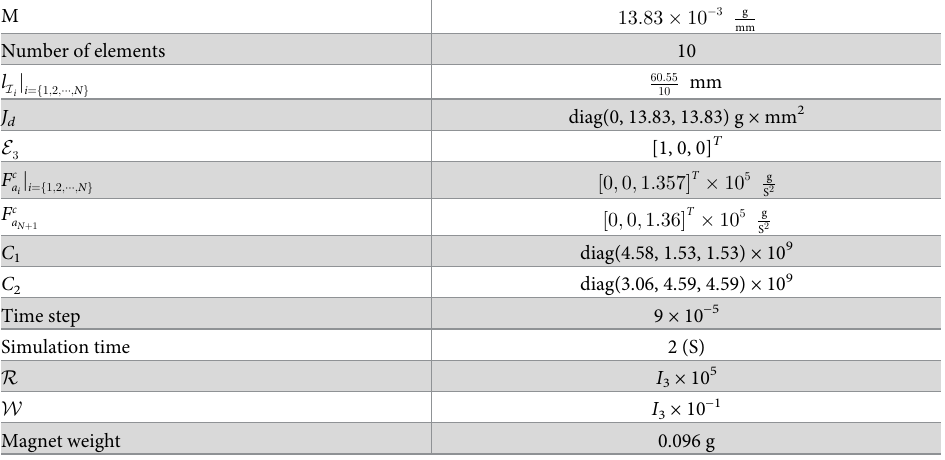
r ¼ 1000 kg , square cross-section with edge length a = 5 cm, Poisson’s ratio ν = 0.35, and m 3 Young’s modulus E = 5 × 10 4 KPa in the high frequency case and E hf pares the position between high and low-frequency cases. The base of the manipulator is fixed at the origin. From Fig 16, it is observed that by changing the Young Modulus from E tip motion is preserved but in a scaled frequency. Table 6. Simulation parameters in Eqs (10)–(16)and (21) for in-plane and circular-motion experiments of PDMS rod (with tip